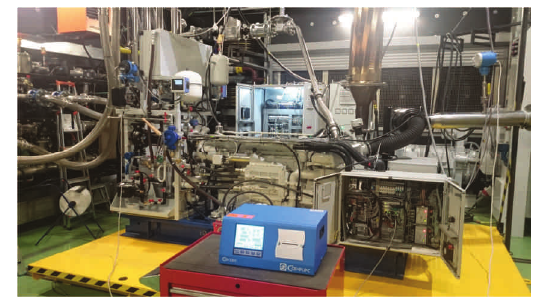
Fig. 6. View of a part of a laboratory test stand with a electric current generator – Horus Energia